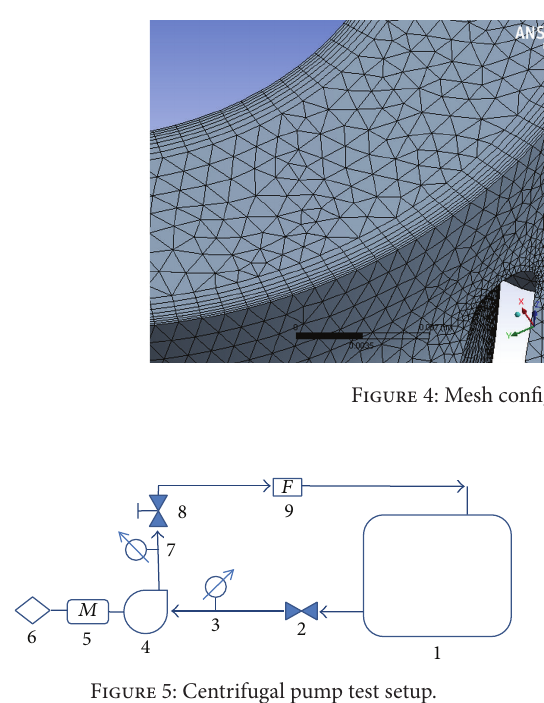
Figure 3: CFD model of the pump (fluid domain).